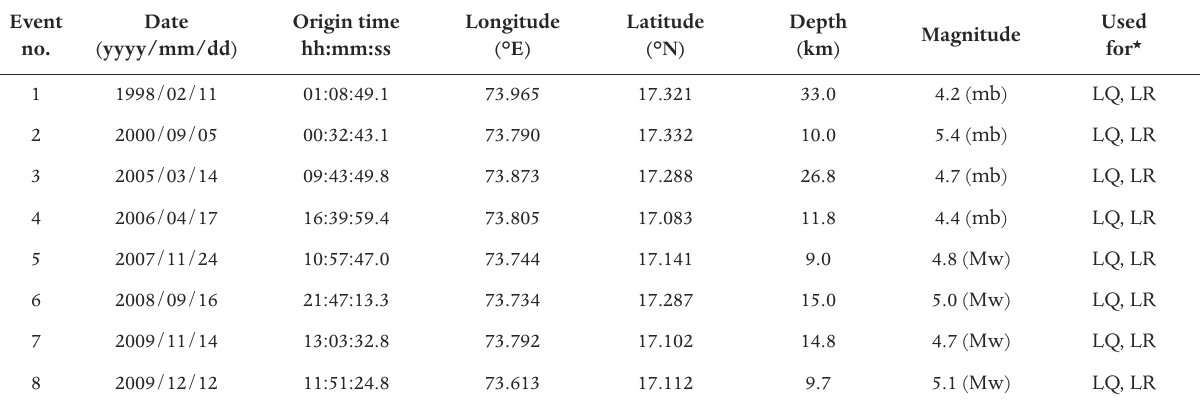
Table 1. List of earthquakes used for evaluating group velocities. *LQ= Love wave, LR=Rayleigh wave.